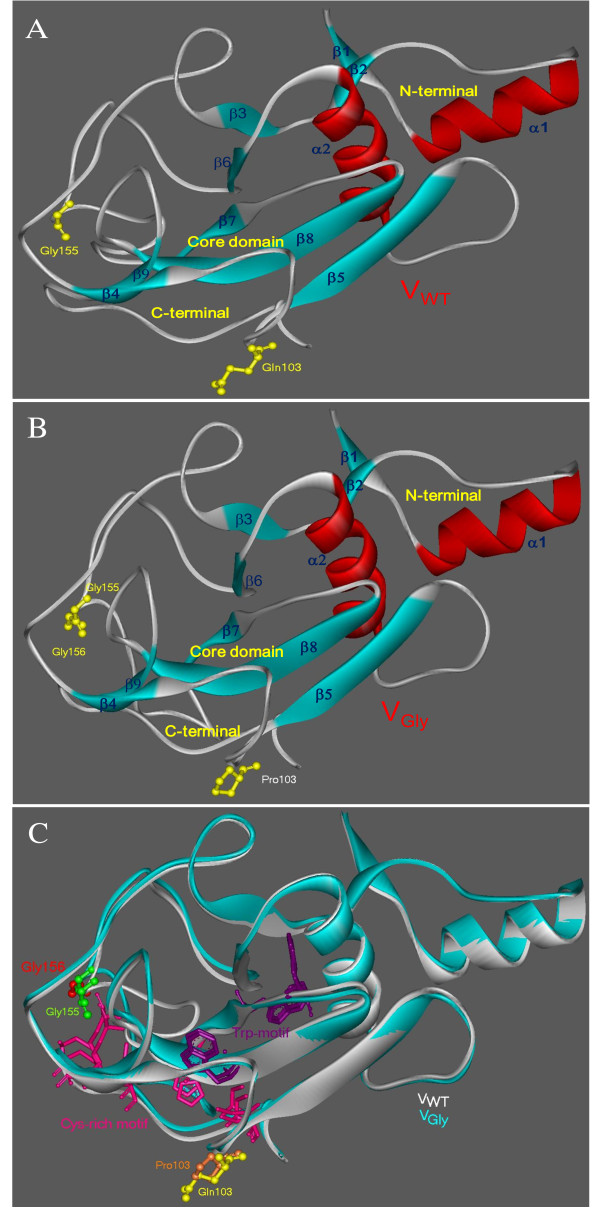
Homologous modeling and differences of theoretical 3D structure of VWT and VGly. (A) Models of V proteins, VWT and (B) VGly built with the PDB: 2B5Lc as template. Both cases show residues 155 and 103. Additionally, residue 156 is shown in B. (C) Superimposition of the 3D models of VWT (gray) and VGly (blue), Gly155 (green), Gly156 of VGly (red), Pro103 of VGly (orange), Gln103 of VWT (yellow), Trp-motif residues of binding to STAT1-STAT2 (purple), Cys-rich motif C4HC3 (residues in pink). Display in Web Lab Viewer.